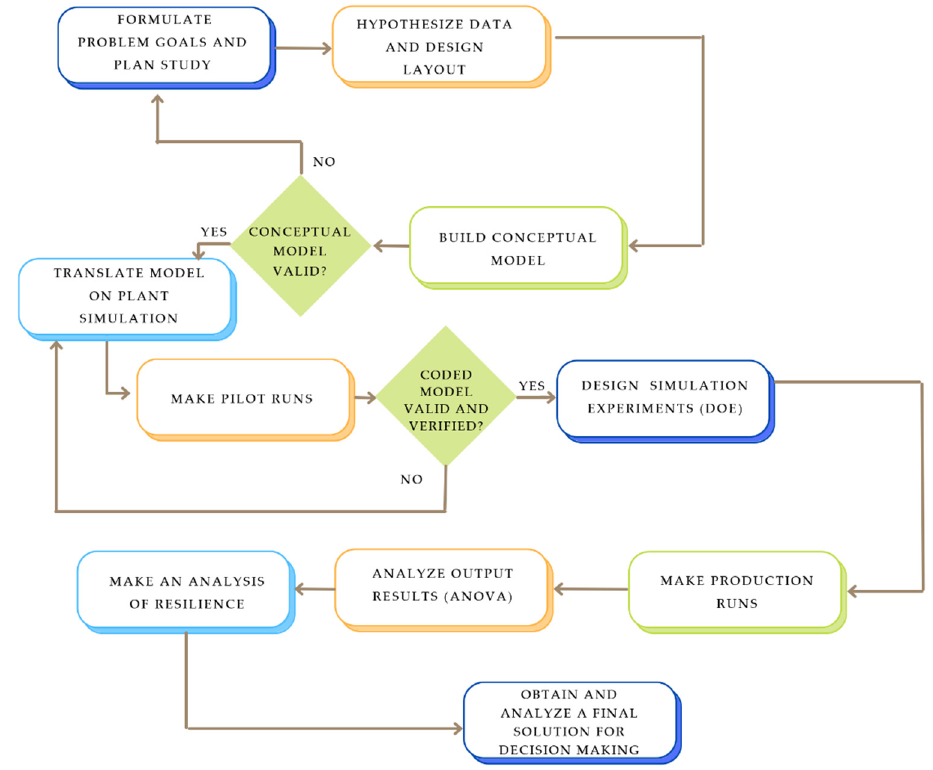
Figure 7. Flow Chart with the main steps of the experimental campaign.